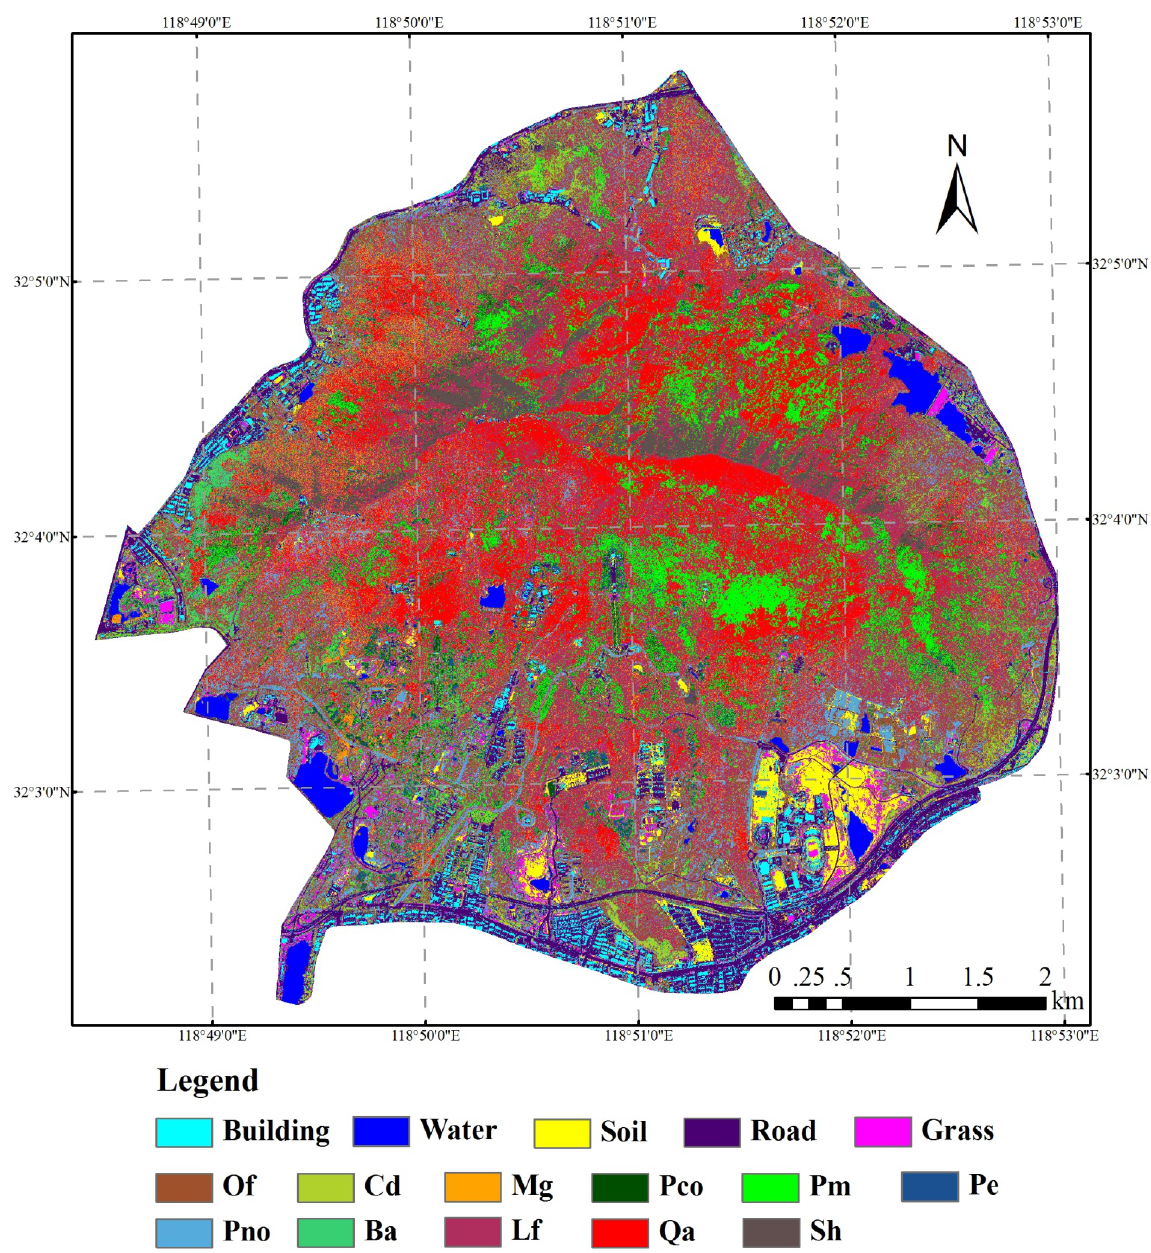
Figure 5. Distribution of 16 classes classified by MultiSpec Win32 for eight multispectral bands. Of: open forest; Cd: Cedrus deodara ; Mg: Metasequoia glyptostroboides ; Pco: Platycladus orientalis ; Pm: Pinus massoniana ; Pe: Pinus elliottii ; Pno: Platanus orientalis ; Ba: bamboo; Lf: Liquidambar formosana ; Qa: Quercus acutissima ; Sh: